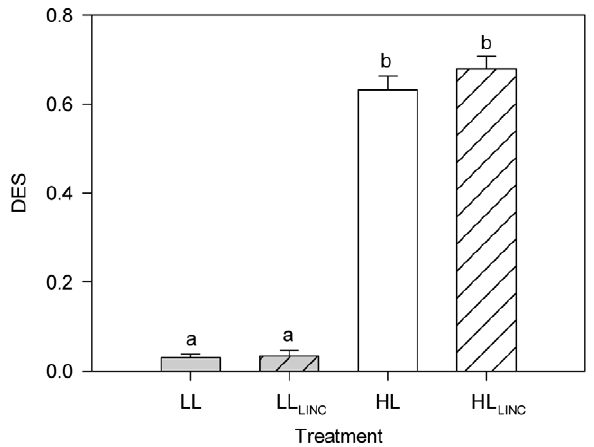
Figure 3. De-epoxidation state (DES) in Phaeodactylumtricornu- tum . Treatments (1 h duration): LL (low light, 40 m mol photons m 2 2 s 2 1 ); HL (high light, 1,250 m mol photons m 2 2 s 2 1 ); LL LINC (low light with LINC); and HL LINC (high light with LINC). Mean 6 standard deviation (n=4). Different letters indicate significant differences between treatments ( P , 0.001). doi:10.1371/journal.pone.0038162.g003 Maximum ( F v / F m ) and effective ( D F / F m 9 ) quantum yield of PSII in P. tricornutum before and during HL and subsequent recovery in the dark are depicted in Fig. 5. Under HL, D F / F m 9 was extremely low ( , 0.05) and stable in both treatments. When transferred to the dark, after the HL period, values recovered gradually, but differently depending on the treatment. In the absence of inhibitor (HL), F v / F m recovered after 1 h in the dark to 0.514 6 0.027. Compared with the initial F v / F m , it represented a 76% recovery. When the PSII repair cycle was blocked by the addition of LINC (HL LINC ), recovery of F v / F m was significantly lower, reaching 0.321 6 0.081 after 1 h in the dark. Recovery of F v / F m was still visible between 30 min and 1 h in the dark in both treatments (HL and HL LINC ).